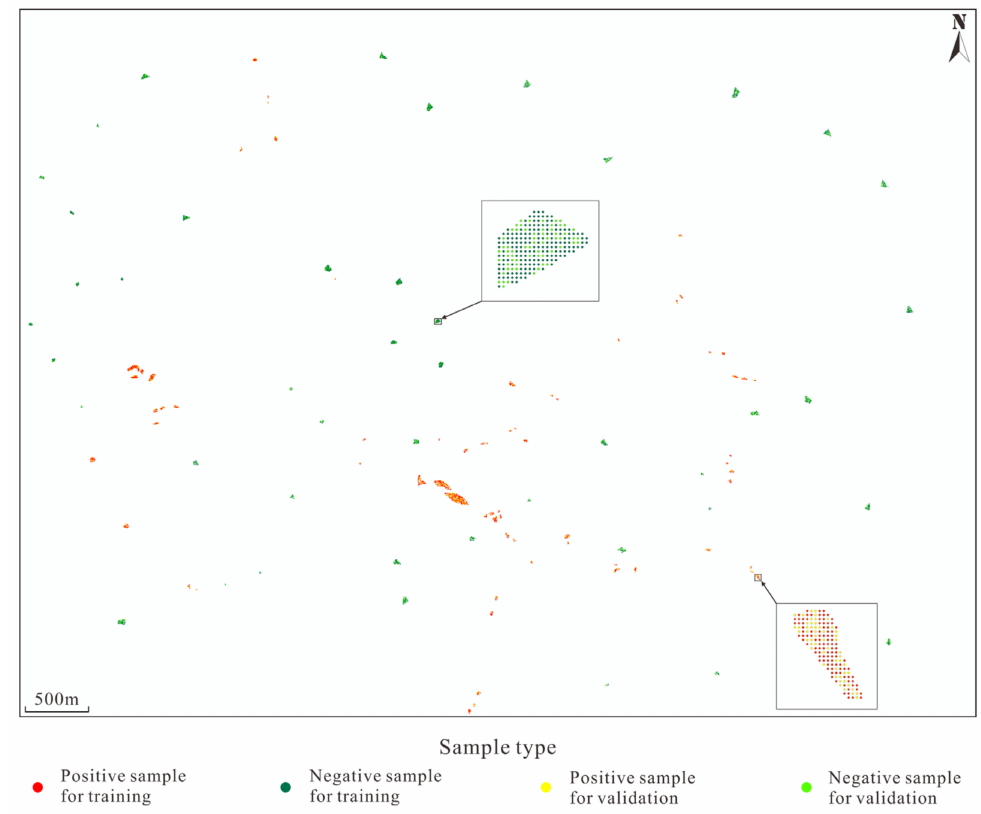
Figure 9. Spatial distribution of the acquired positive and negative samples in the training and validation sets for construction of RF-based prediction model for MGM of the study